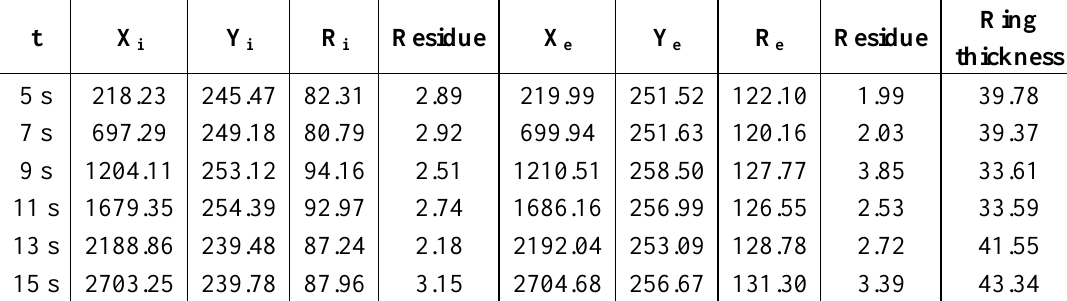
Table 3. Centre and radius adjustments [mm].